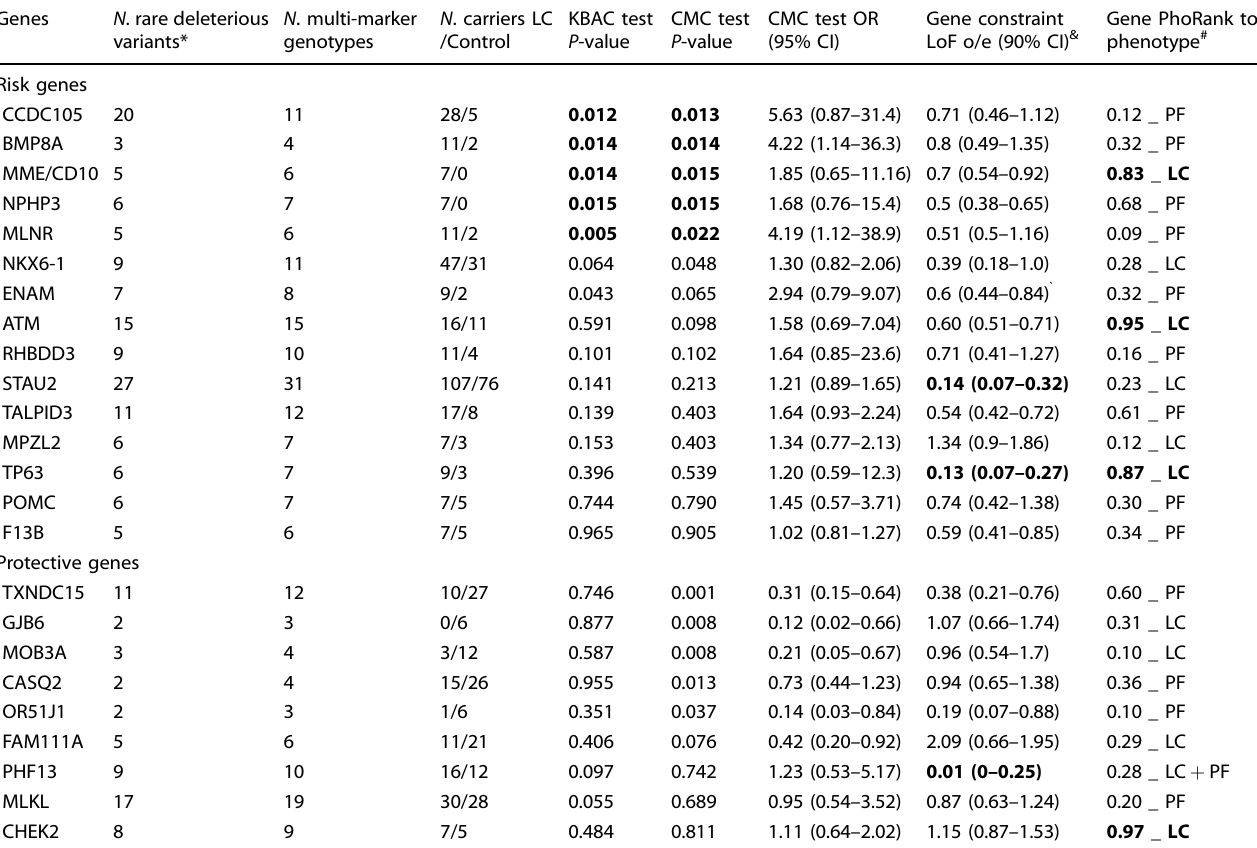
Table 2. Gene-based association tests in the TRICL study, ranked by P -value from the combined multivariate and collapsing